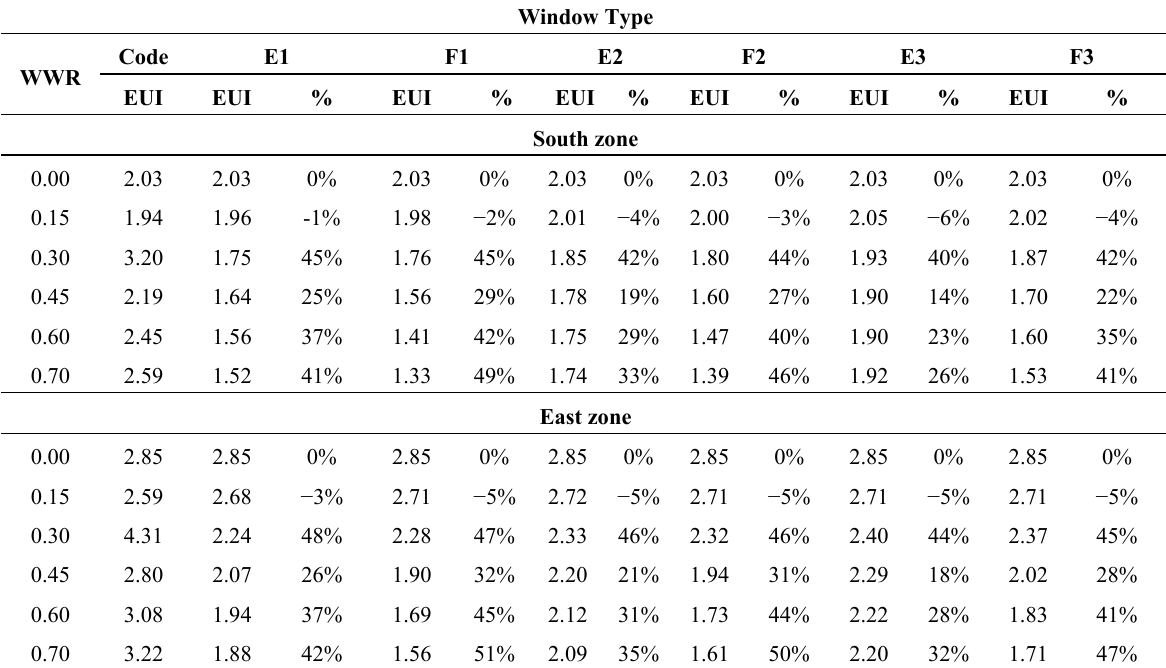
Figure 5. Disaggregated energy use (MJ/m 2 -year) for perimeter zones in Shanghai. Table 10. Zone heating load (MJ/m 2 -year) and percent savings compared to the GB 50189-2005 Standard for